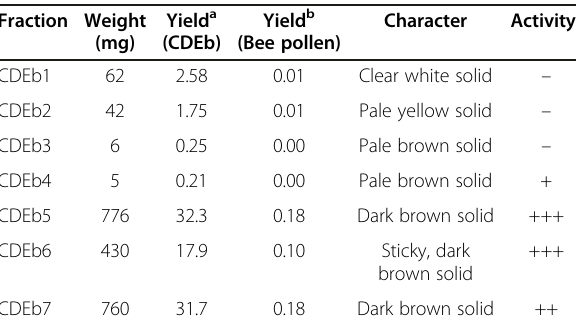
Table 3 The weight and character of the seven different active fractions following silica gel quick